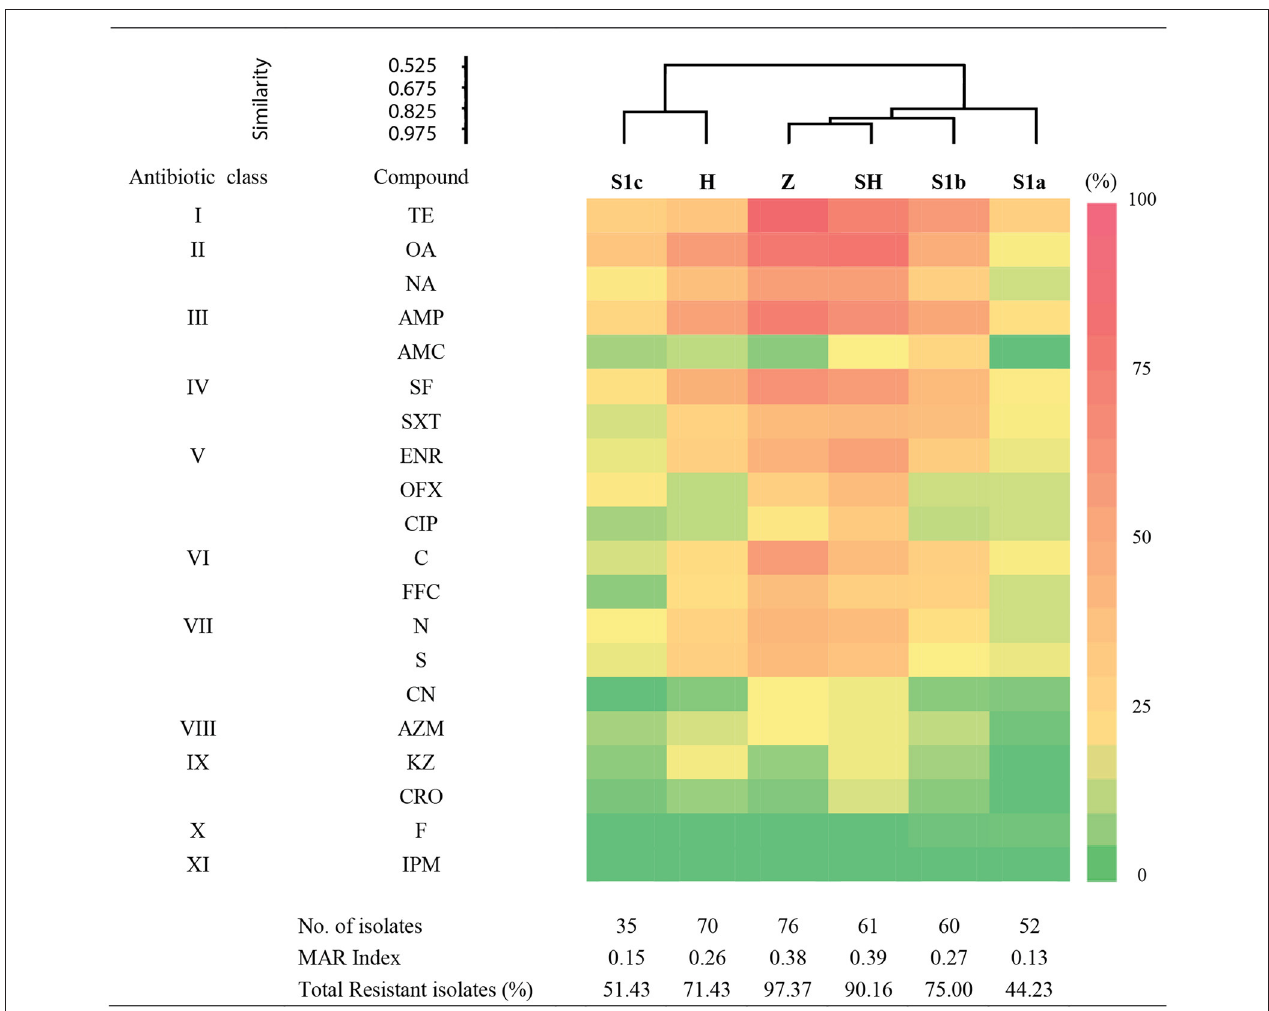
FIGURE 3 | Antibiogram of antibiotic resistance phenotype detected in surface water among sampling sites in Larut River organied by similarity. Abbr, abbreviation. Antibiotic class: I, Tetracycline; II, Quinolone; III, Penicilin; IV, Sulfonamide; V, Fluoroquinolone; VI, Amphenicol; VI, Aminoglycoside; VIII, Macrolide; XI, Cephalosporin; X, Nitrofuran; XI, Carbapenem. Antibiotic type: TE, Tetracycline; OA, Oxolinic acid; NA, Nalidixic acid; AMP, Ampicilin; AMC, Amoxycillin/Clavulanic acid; SF, Sulfafurazole; SXT, Sulfamethoxazole/trimethoprim; ENR, Enrofloxacin; OFX, Ofloxacin; CIP, Ciprofloxacin; C, Chloramphenicol; FFC, Florfenicol; N, Neomycin; S, Streptomycin; CN, Gentamicin; AZM; Azithromycin; KZ, Cephazolin; CRO, Ceftriaxone; F, Nitrofurantion; IPM, Imipenem. Sampling sites: Z, Zoo; H, Hospital; SH,